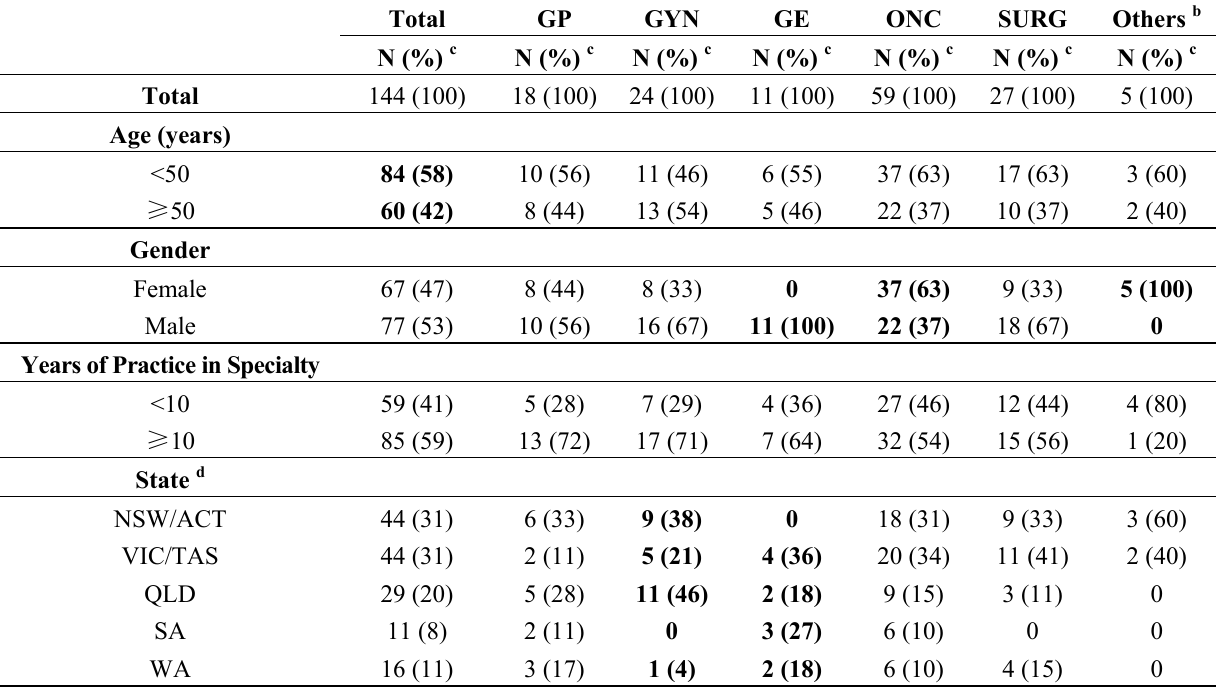
Table 1. Sociodemographics of participating health care provider groups a